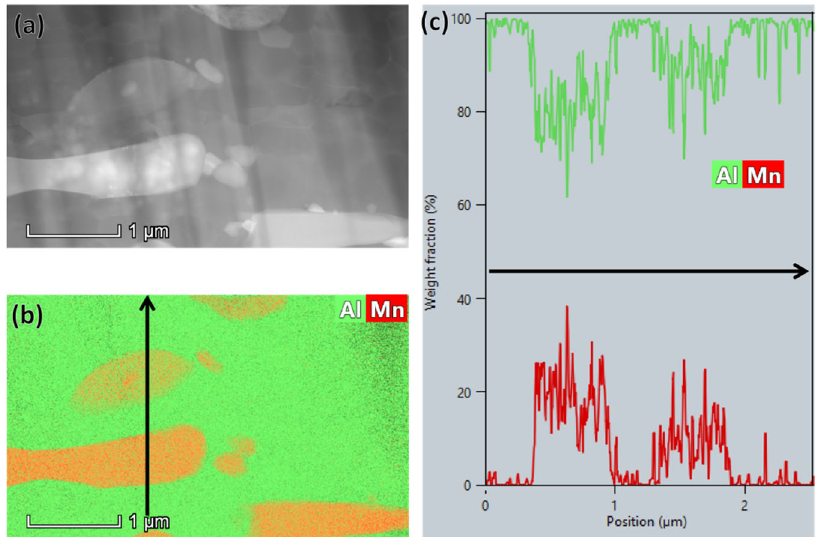
Fig. 4 HAADF images and composition of Mn-rich particles in the topmost surface layer of GG Al – Mn sample. a HAADF image. b EDS- mapping of Al and Mn elements and c EDS line scan pro fi le of the black arrowed line in ( b